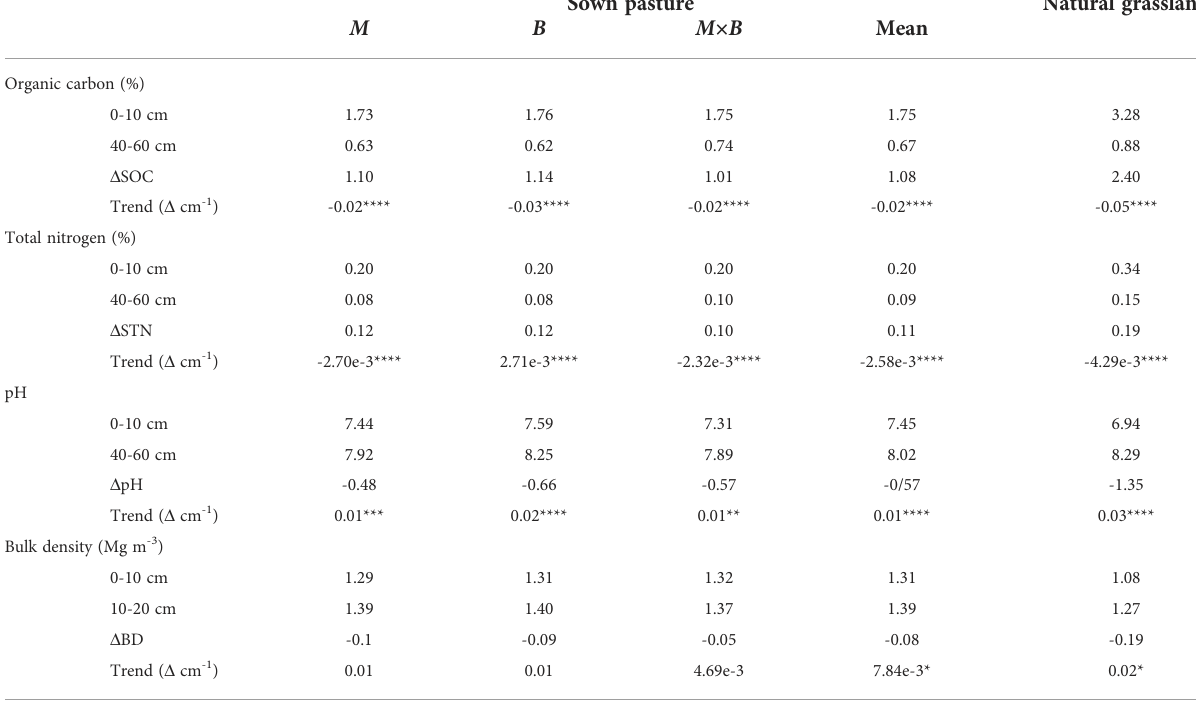
TABLE 3 Vertical variations and trends in soil physicochemical properties over soil depth in sown pastures versus the natural grassland.